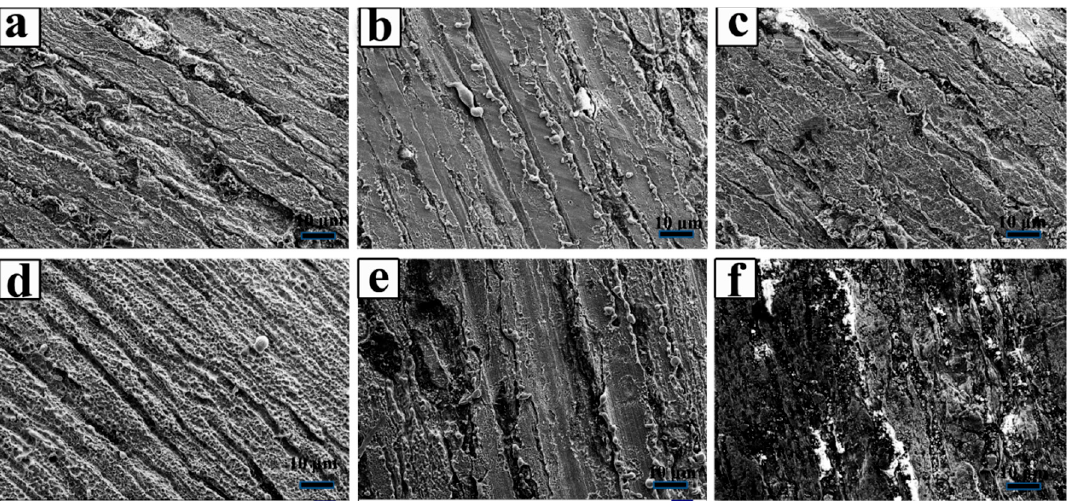
Figure 3. Field emission scanning electron microscopy (FESEM) image of Q195 carbon structural